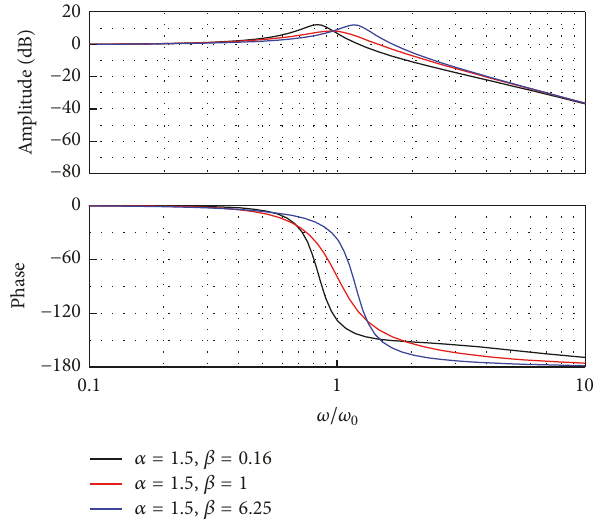
Figure 17: Amplitude-frequency characteristic and phase-fre- quency characteristic ( 𝛼 = 1.5, 𝛽 = 0.16, 1, 6.25